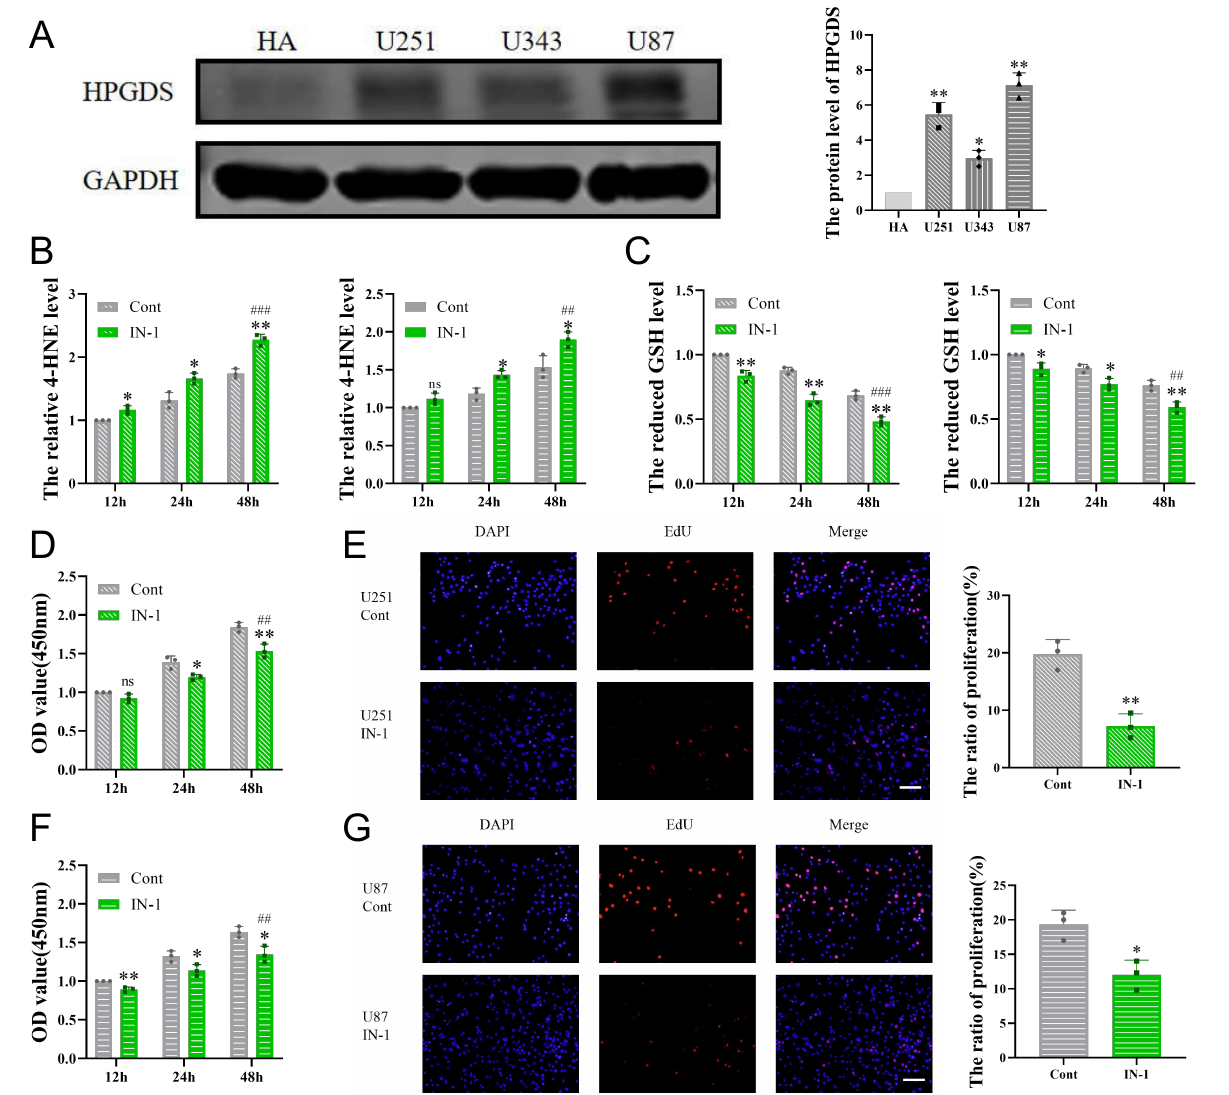
Figure 7. Effects of microwave pretreatment on the composition and content of phytosterols in Figure 7. HPGDS is highly expressed in GBM and affects the cellular redox status and proliferation. rapeseed cake. Values are the means standard deviations; n = 3 parallel determinations. a–d Mean ( A ) The levels of HPGDS protein in GBM cell lines are significantly higher than in normal glial cell ± values (a > b > c > d, corresponding to the same parameter) not followed by a common letter differ lines. ( B , C ) Inhibition of HPGDS resulted in an accumulation of 4-HNE and a decrease of intracellular significantly ( p < 0.05). GSH in GBM cells. ( D – G ) The effects of inhibition of HPGDS on the proliferation of U251 and U87 cells were detected by CCK8 and EdU assays. * p < 0.05, ** p < 0.01; ## p < 0.01, ### p < 0.001, ns: p >